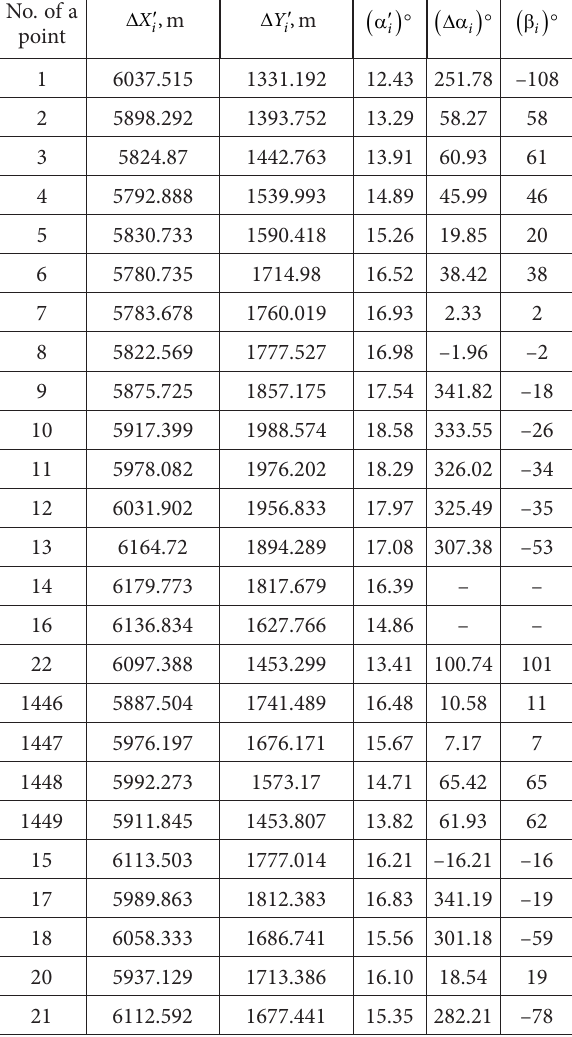
Table 3. The value of the directional angles from the points to